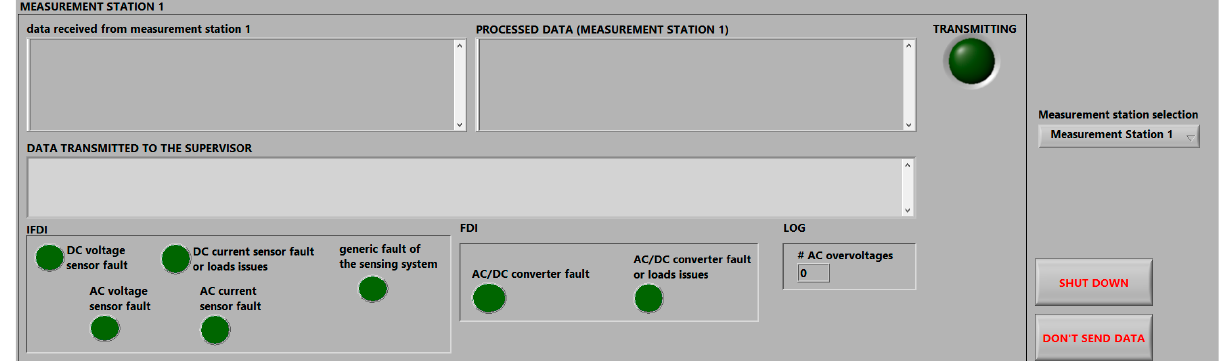
Figure 6. Front panel of the diagnostic system LabVIEW program.